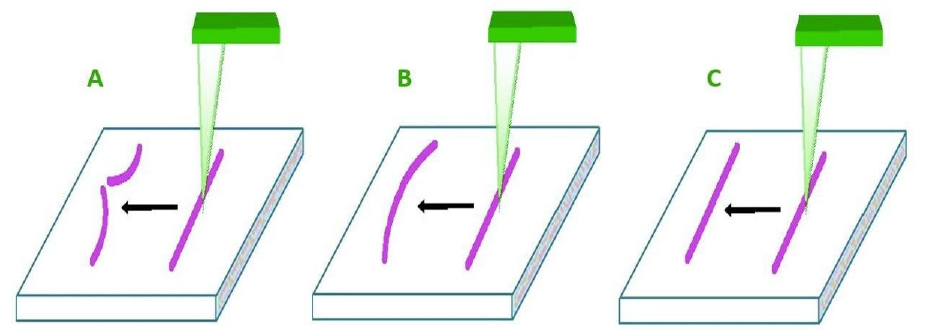
Figure 4. Three possible impacts: ( A )—rigid nanorod, ( B )—fluid nanorod, ( C )—elastic nanorod [16]. Reprinted with permission from ref. [16]. Copyright 2012 Open access peer-reviewed